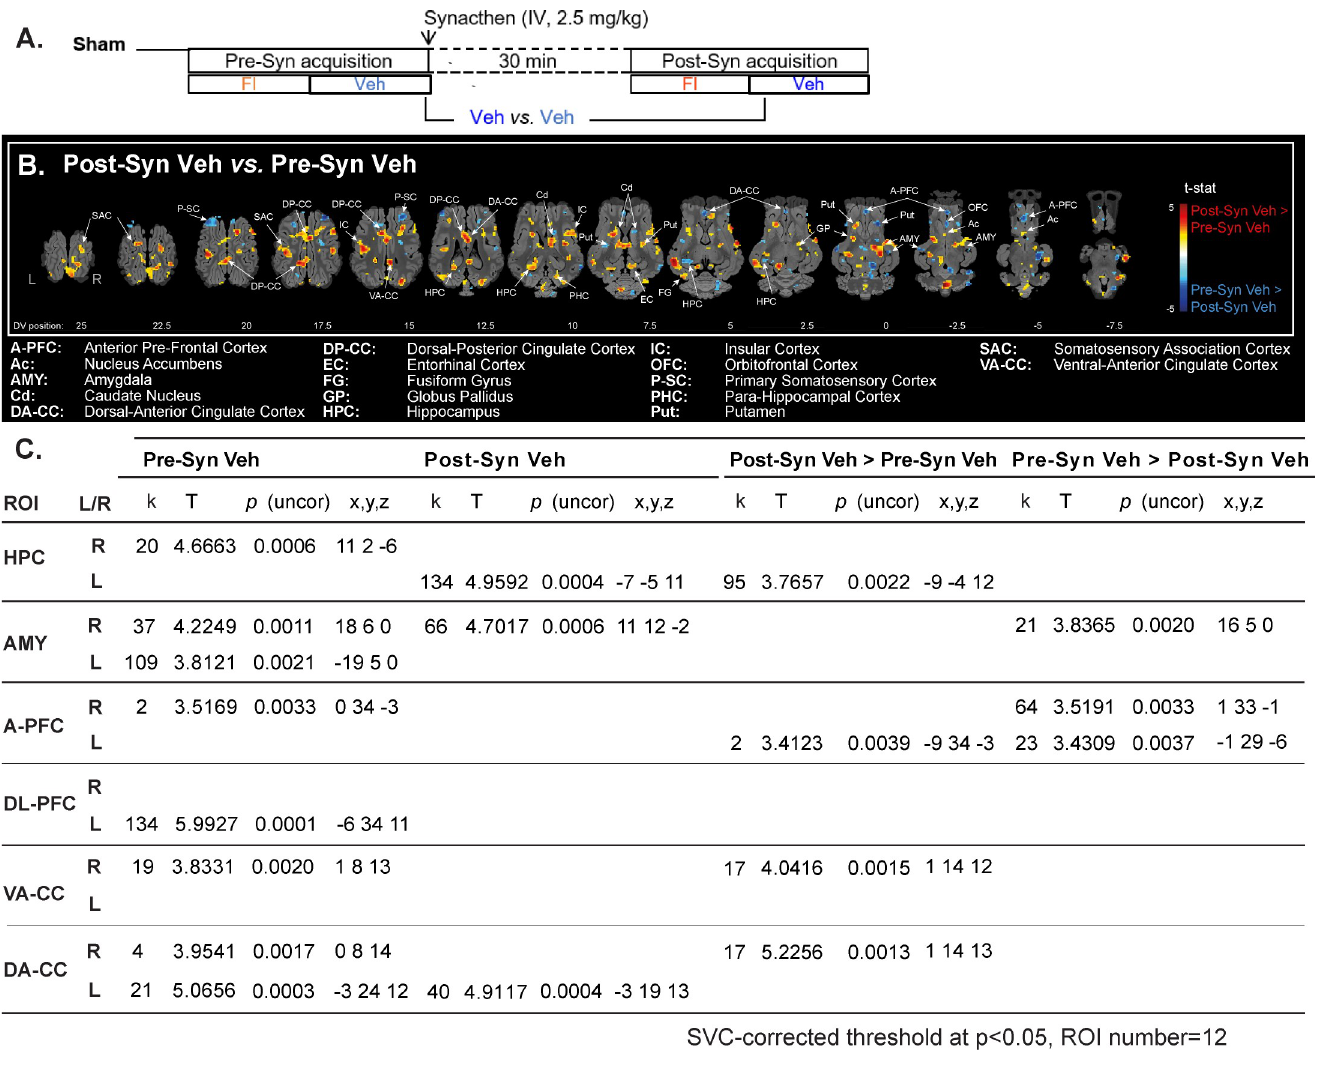
Fig 5. Pharmacological stress increased activity in several brain regions. (A) Brain activity during vehicle stimulation and responses to the injection of the pharmacological ACTH agonist (Synacthen 1 ) in condition of vehicle stimulation were assessed in Sham animals (n = 10). FI: Olfactory stimulation with the food ingredient, Veh: Neutral stimulation with the vehicle. (B) Horizontal maps of brain BOLD responses to the injection. p-value threshold = 0.05, k > 20, DV: Dorsal- ventral position related to the posterior commissure (in mm). The part of the frontal cortices that was not covered with the average BOLD-based statistical maps is superimposed in dark grey on the anatomical maps. (C) SVC-based statistics: Related regions of interest (ROIs) with uncorrected p-value that reached the criteria of p < 0.05 after Bonferroni correction.